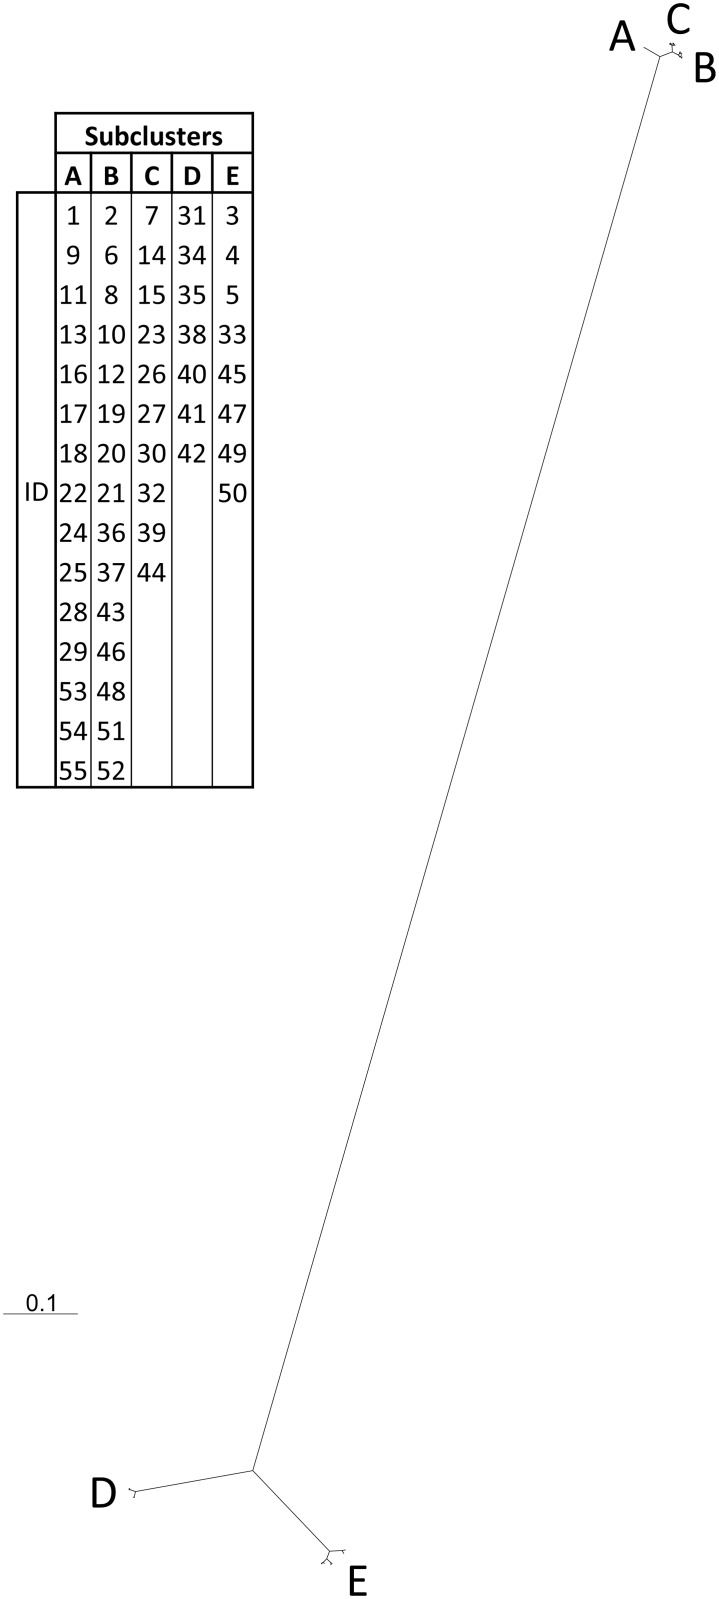
Ecological and genetic relationships among Italian Culex pipiens populations.The dendrogram evaluated the Culex pipiens population genotype frequencies by UPGMA cluster analysis, based on the Nei 72 algorithm.